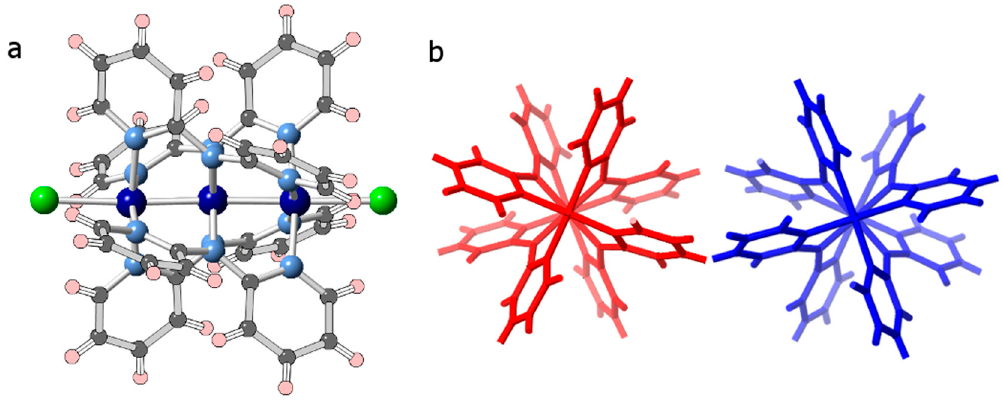
Figure 1. ( a ) Ball and stick representation of [Co 3 (dpa) 4 Cl 2 ]. Cobalt: dark blue, nitrogen: light blue, chlorine: green, carbon: gray, hydrogen: pink; ( b ) Representation along the M − M − M axis of [ Δ -Co 3 (dpa) 4 Cl 2 ] (red) and [ Λ -Co 3 (dpa) 4 Cl 2 ] (blue). Figures generated from X-ray diffraction data.